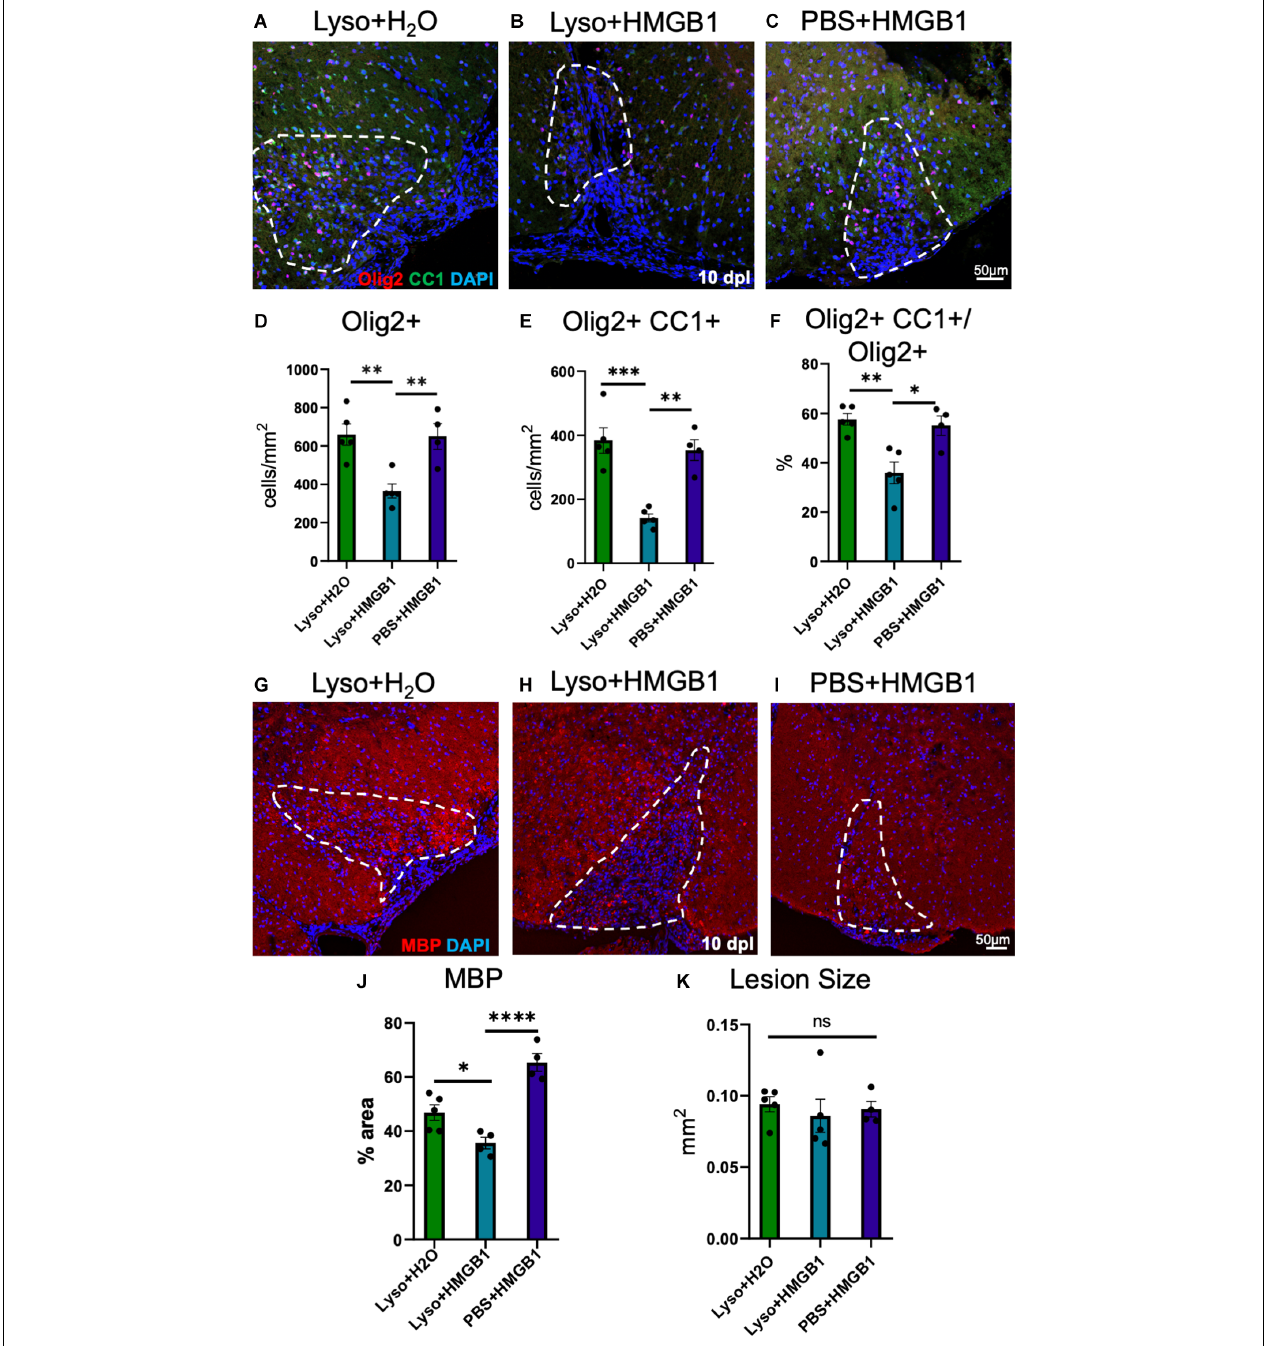
FIGURE 1 | HMGB1 reduced evidence for myelination after LPC-induced demyelination. (A) A representative IHC image of mouse spinal cord injected with 1 µ l LPC (1.0%) and water control 10 days post lesion (dpl) stained with Olig2, CC1, and DAPI. (B) A representative IHC image of mouse spinal cord co-injected with 1 µ l LPC (1.0%) and 1 µ l rhHMGB1 (1 mg/ml in water) at 10 dpl stained with Olig2, CC1, and DAPI. (C) A representative IHC image of mouse spinal cord injected with PBS and 1 µ l rhHMGB1 (1 mg/ml in water) at 10 days post injection stained with Olig2, CC1, and DAPI. (D) Quantification of the number of Olig2+ cells. (E) Quantification of the Olig2+ and CC1+ cells. (F) Percent of Olig2+ cells that were also CC1+. (G) Representative image of mouse spinal cord injected with 1 µ l LPC (1.0%) and water control 10 dpl stained for myelin basic protein (MBP) and DAPI. (H) A representative IHC image of mouse spinal cord co-injected with LPC and rhHMGB1 at 10 dpl stained for myelin basic protein (MBP) and DAPI. (I) A representative IHC image of mouse spinal cord injected with PBS and 1 µ l rhHMGB1 (1 mg/ml in water) at 10 days post injection stained for myelin basic protein (MBP) and DAPI. (J) Percent of the lesion area that was MBP+. (K) Quantification of the area of the lesion in mm 2 . White dashed lines indicate lesion/injection site. Two to six spinal cord sections from each mouse were used for quantification, 3–5 mice per condition. ∗∗∗∗ P ≤ 0.0001; ∗∗∗ P ≤ 0.001; ∗∗ P ≤ 0.01; and ∗ P ≤ 0.05. ns when P > 0.05. Scale bar = 50 µ m.